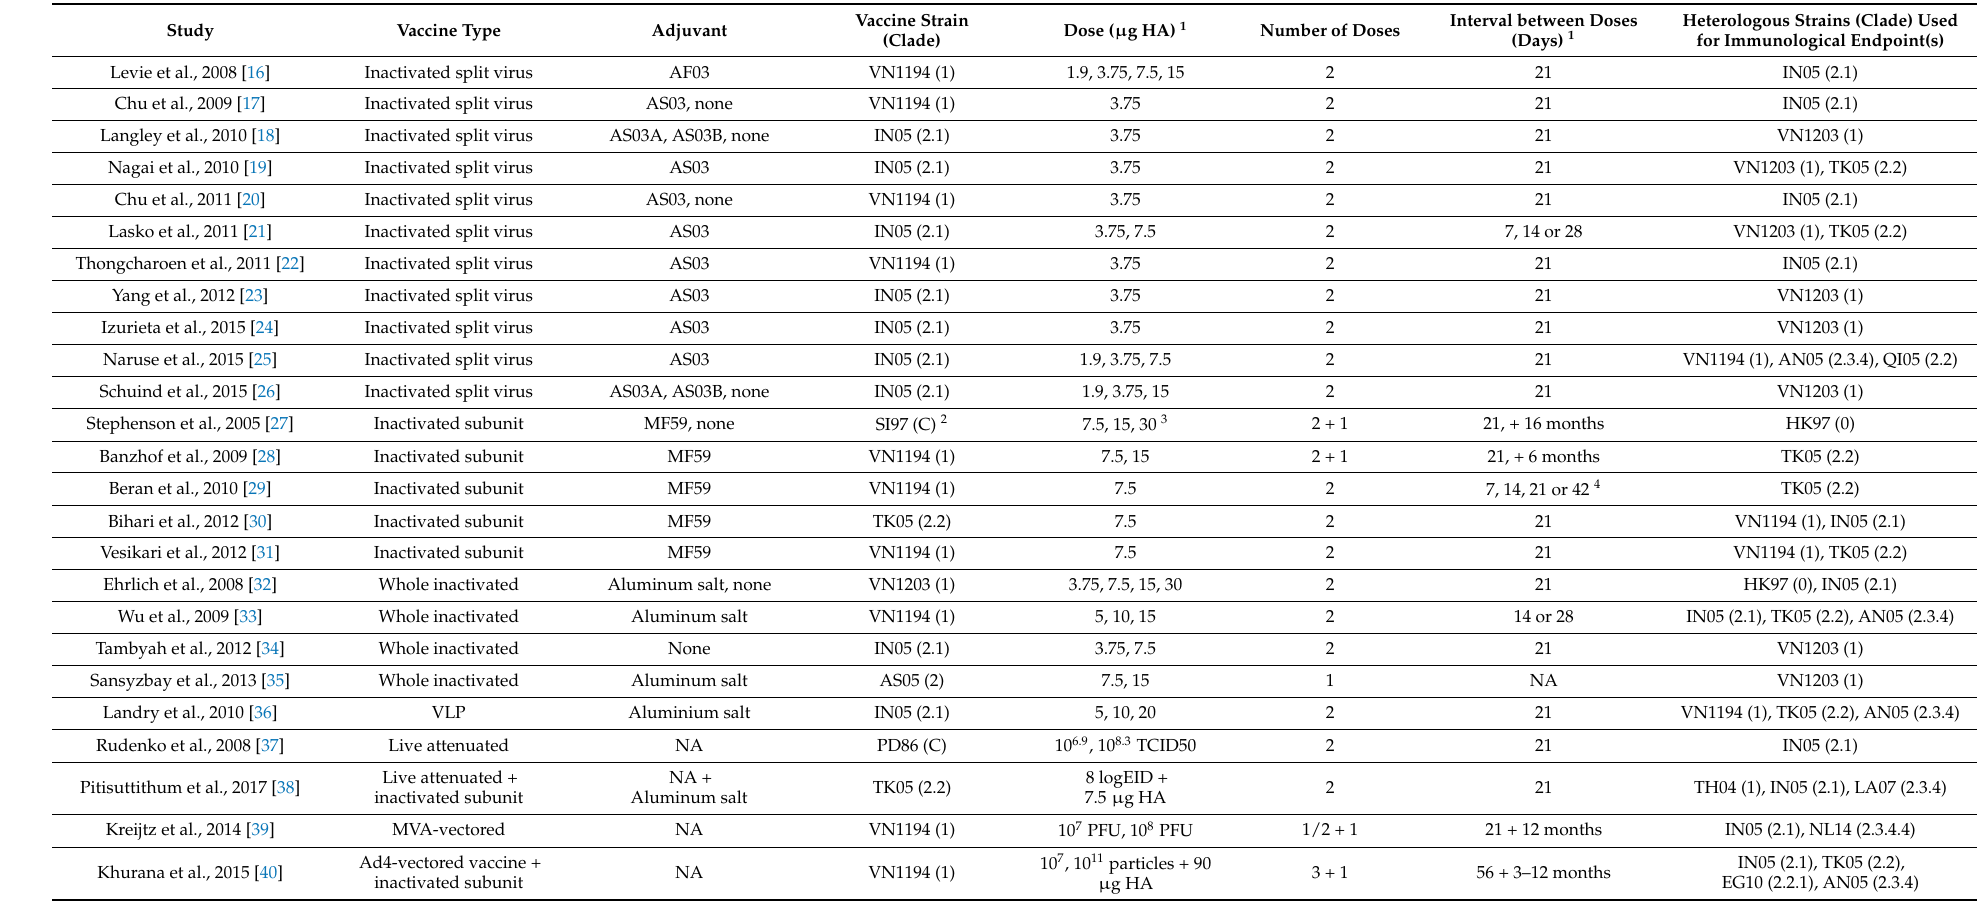
Table 1. Overview of the articles selected for the homologous prime-boost vaccination